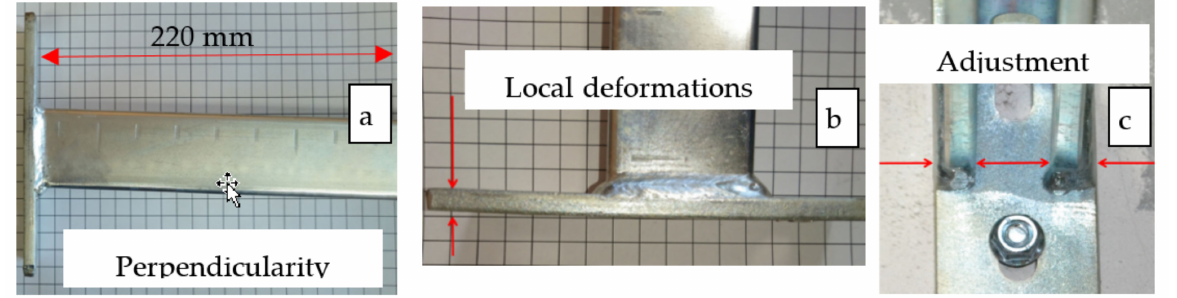
Figure 3. Welded strut design defects: loss of perpendicularity ( a ), deformation of the fastening part ( b ), and defect of the adjustment of the fastening position relative to the support part ( c ). Standard profile of 40 mm × 40 mm cross-section